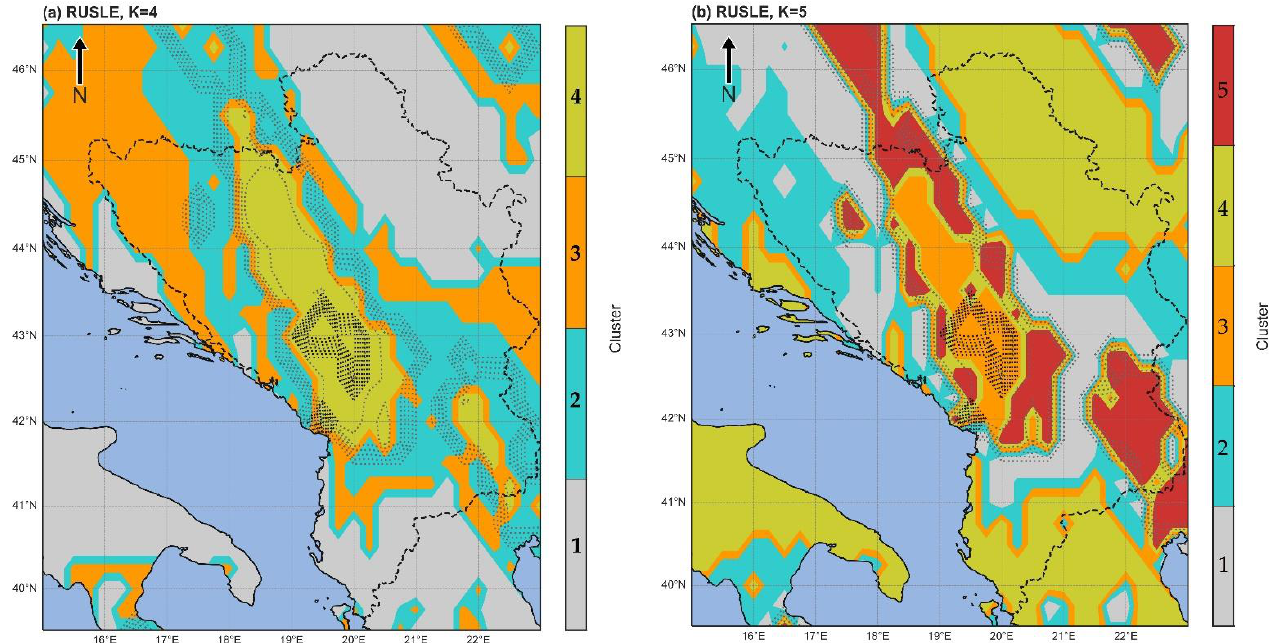
Figure 8. k-means clustering of R-factors calculated by the RUSLE methodology when ( a ) K = 4 and ( b ) K = 5. Light grey dotted lines present R-factor values >400 mm ha −1 h −1 yr −1 , and dark grey dotted lines are R-factor values >600 mm ha −1 h −1 yr −1 .